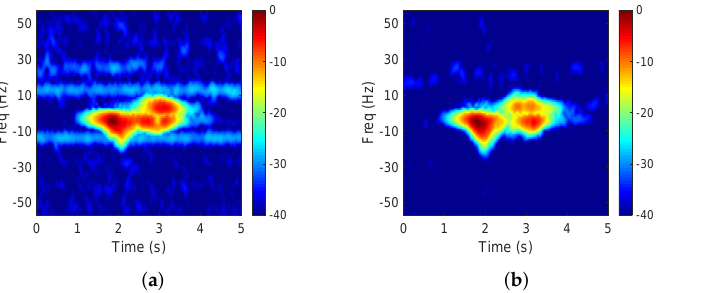
Figure 2. Micro-Doppler signature of standing-up ( a ) with live wire effect, and ( b ) without live wire